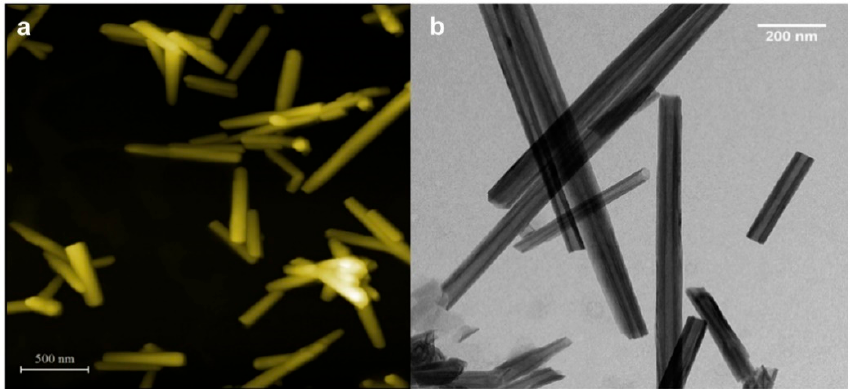
Figure 1. Detail of schematic illustration of the crystalline structure of halloysite nanotubes.